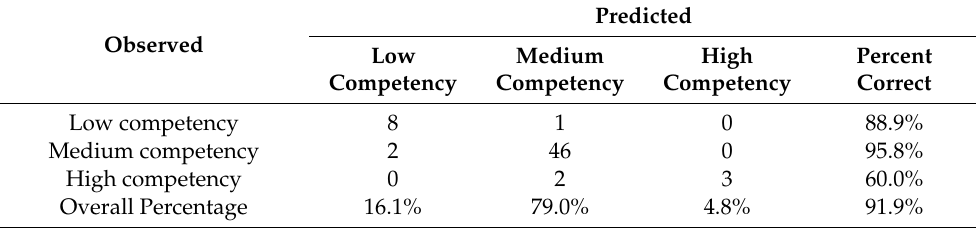
Table 7. Contingency table for obtained classification by model MC4 for variables in group